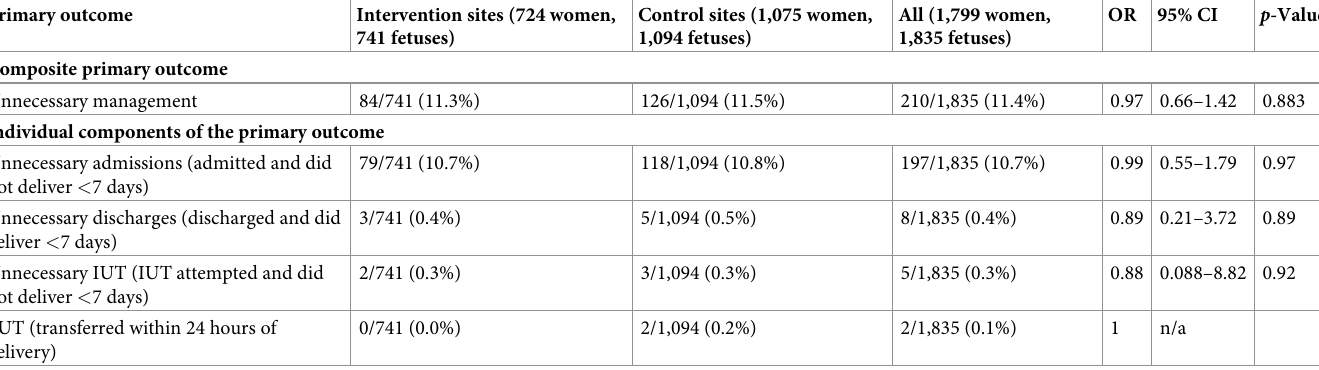
Table 2. Impact of QUiPP app on the primary outcome (TPTL unnecessary management composite and individual components of composite) at intervention sites using QUiPP app versus control sites using conventional management.